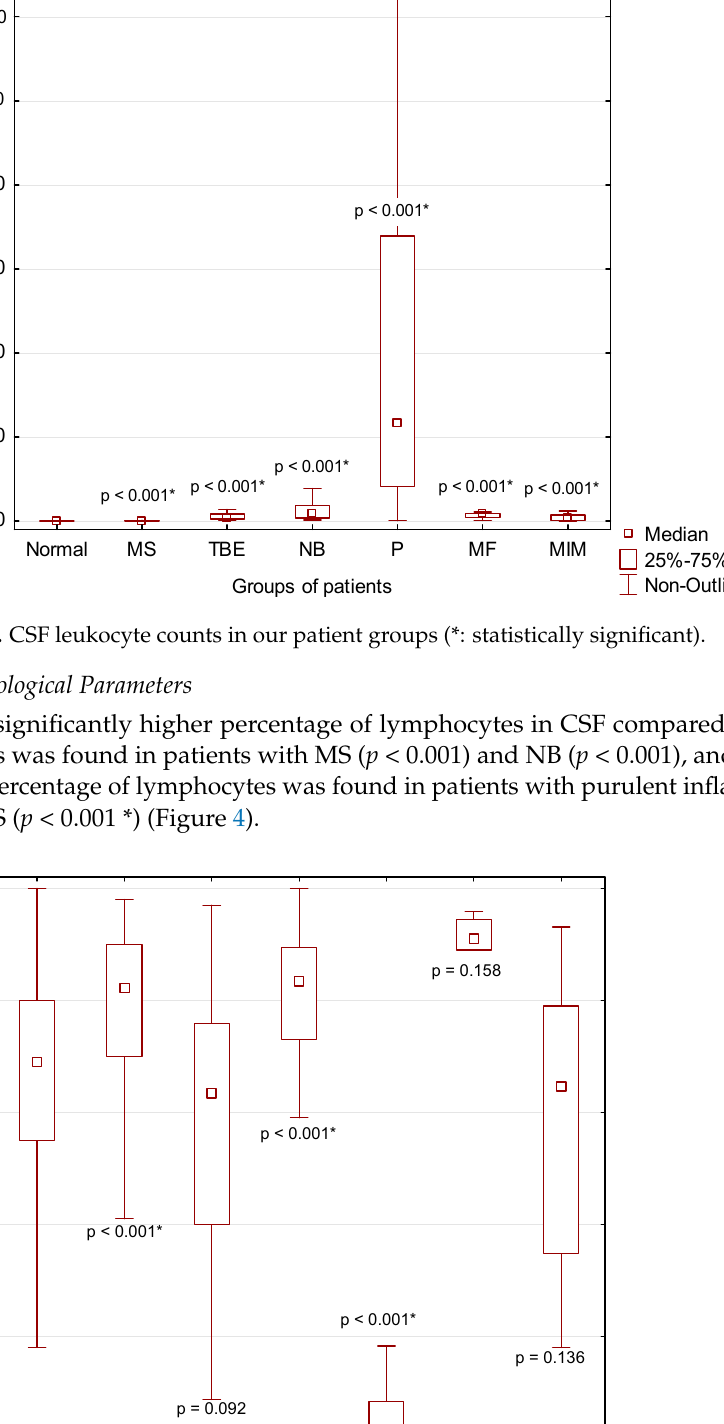
Figure 2. CSF total protein concentrations in our patient groups (*: statistically significant).